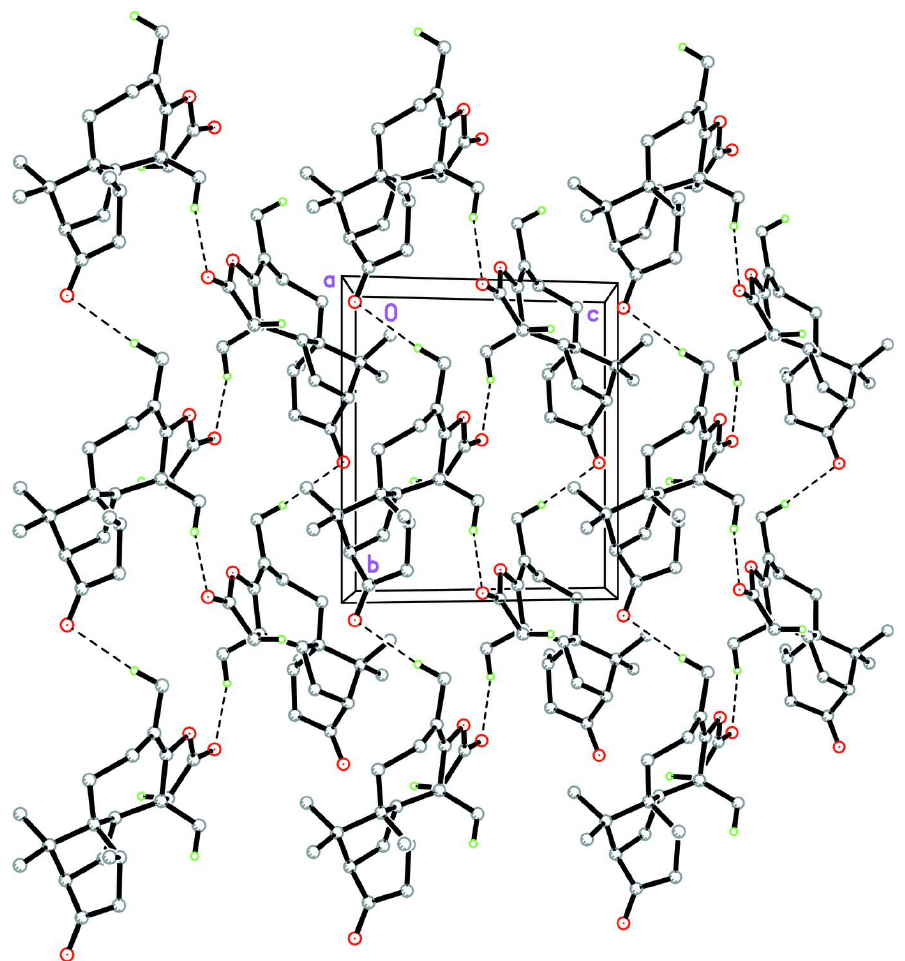
The crystal packing of the title compound viewed along the a axis, showing screw chains. Only H atoms involved in hydrogen bonds were shown for clarity. Hydrogen bonds are shown as dashed